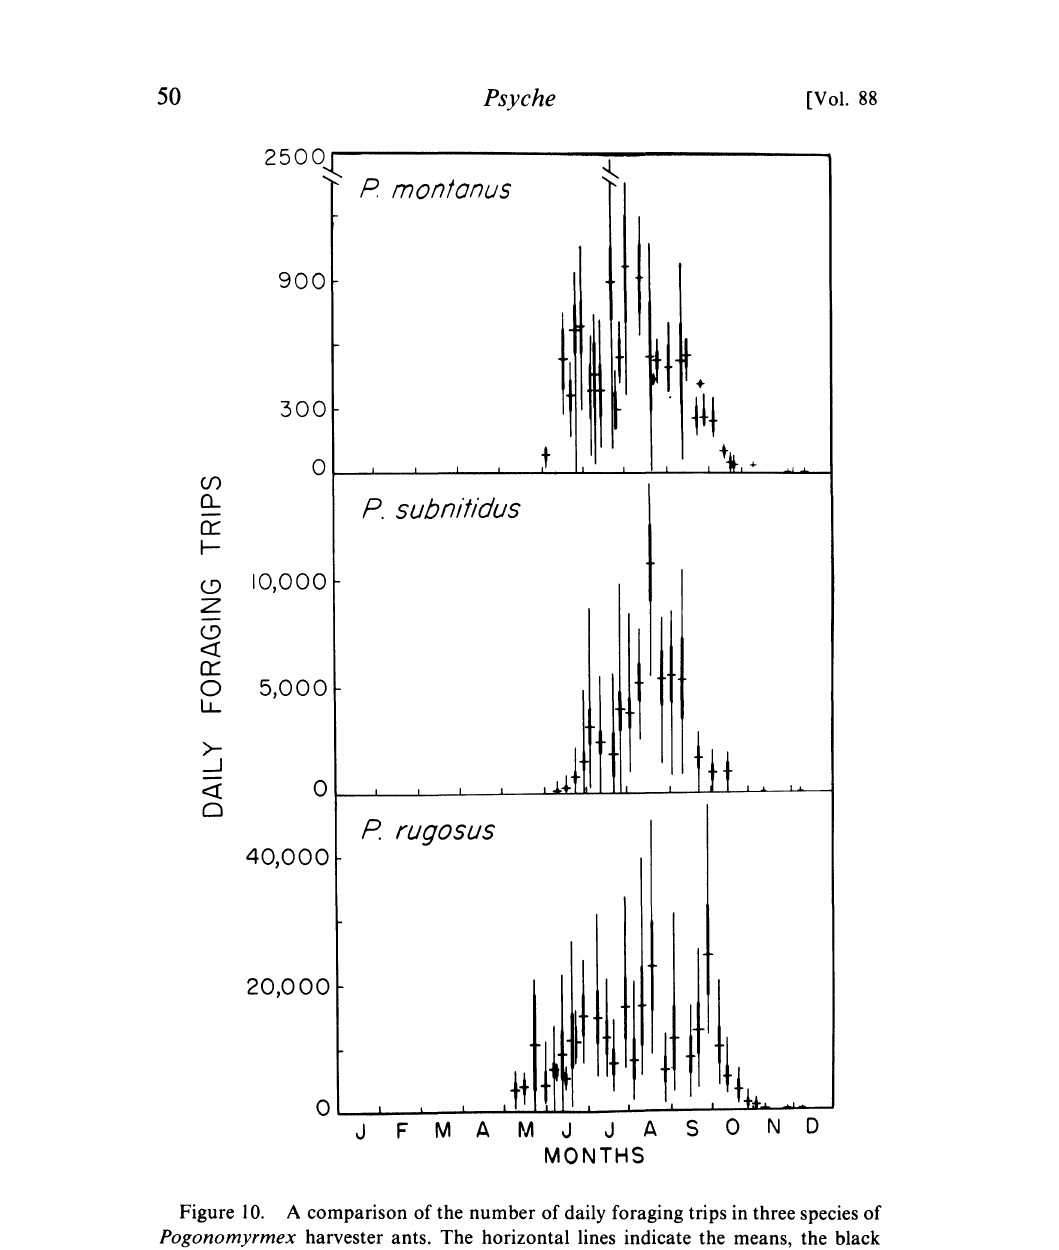
Figure 10. A comparison of the number of daily foraging trips in three species of Pogonomyrmex harvester ants. The horizontal lines indicate the means, the black rectangles the standard errors on each side of the mean, and the vertical lines indicate the